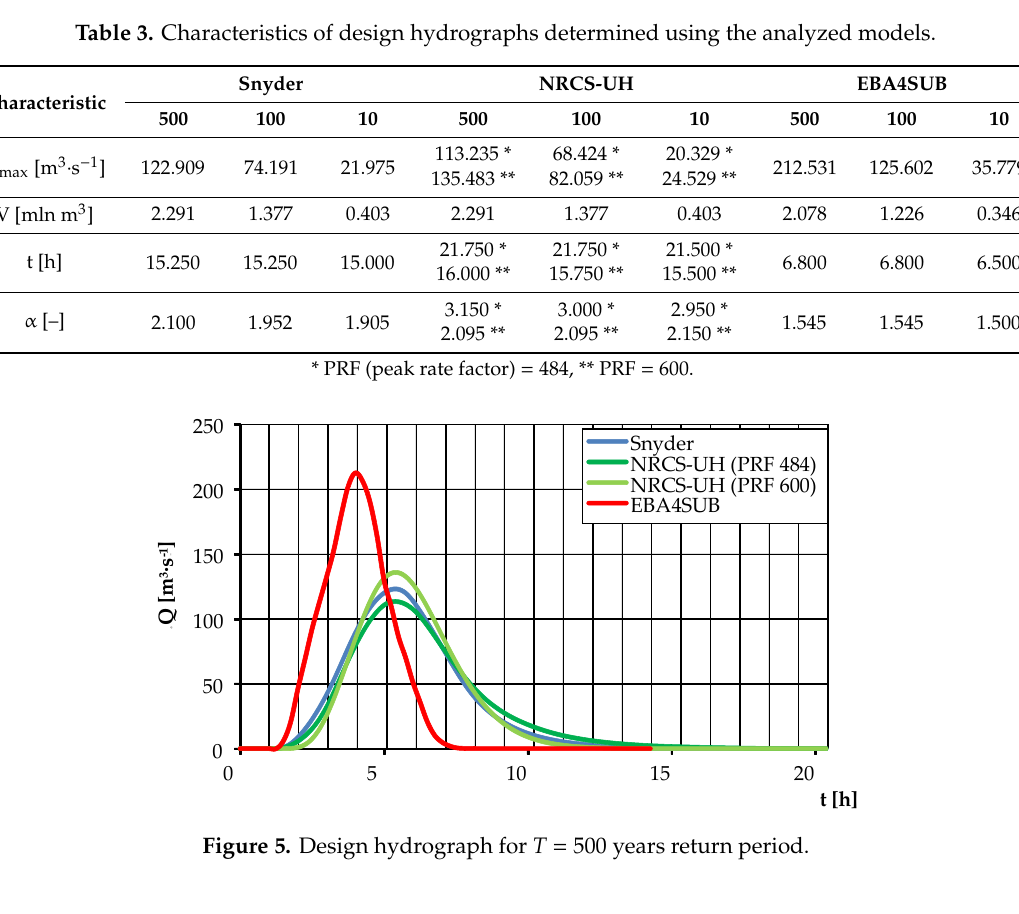
Figure 6. Design hydrograph for T = 100 years return period. Figure 7. Design hydrograph for T = 10 years return period. Based on the results summarized in Table 3 and Figures 5–7, it was found that the highest values of peak flows were obtained using the EBA4SUB model. This is due to the fact that the